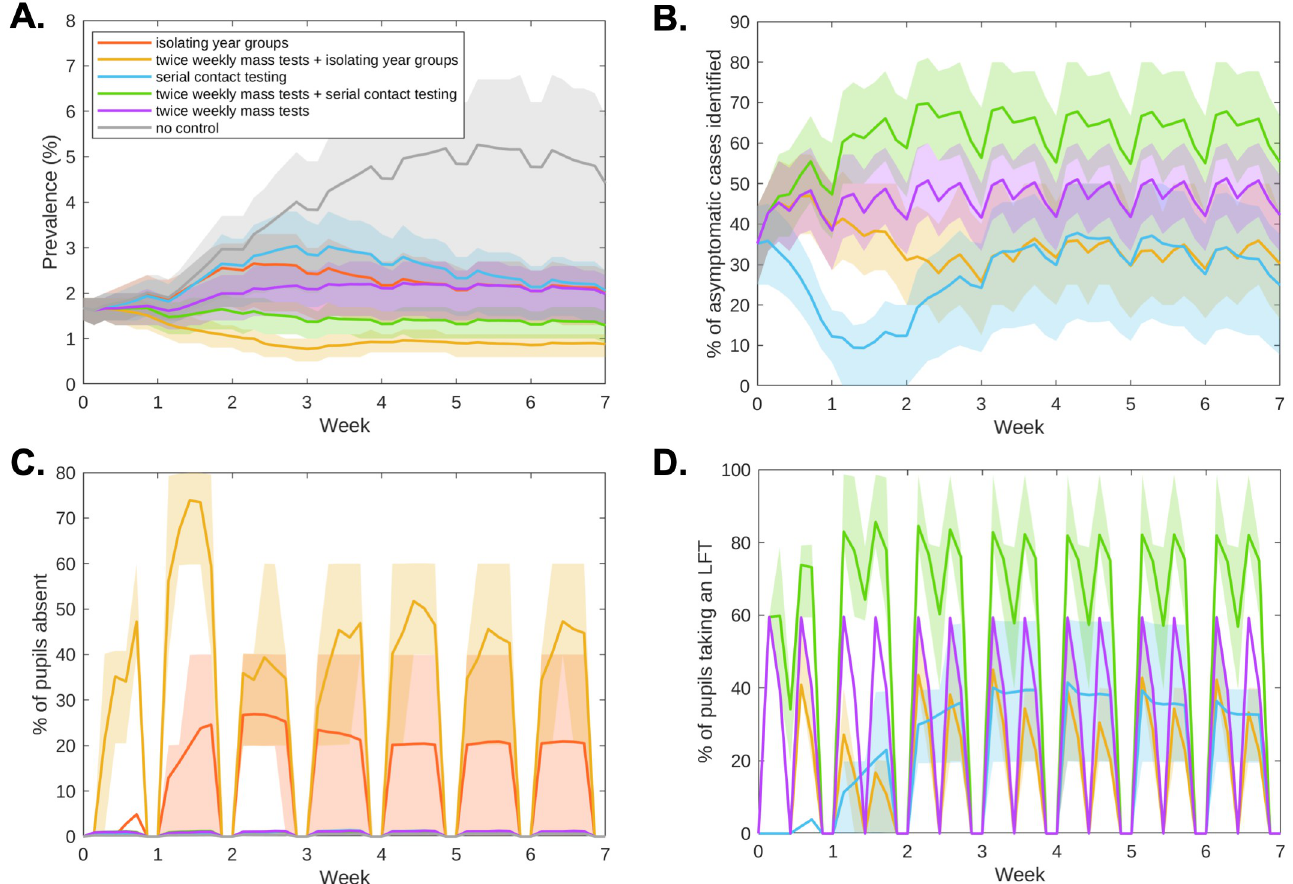
Fig 2. Infection, absences, and testing over the duration of the school half-term. We display timeseries of (a) prevalence, (b) the percentage of currently infectious asymptomatic individuals identified for reopening strategies involving within-school testing. We display timeseries of (c) the percentage of pupils absent and (d) percentage of pupils tested throughout the half-term. Solid line traces correspond to the mean value attained on each daily timestep and shaded envelopes represent the 50% prediction intervals (these regions contain 50% of all simulations at each timepoint). The strategies displayed are: no control (grey), twice weekly mass testing (purple), serial contact testing (blue), isolating year group bubbles strategy (orange), combined twice weekly mass testing and serial contact testing (green), combined twice weekly mass testing and isolation of year group bubbles (yellow). Results produced from 10,000 simulations.